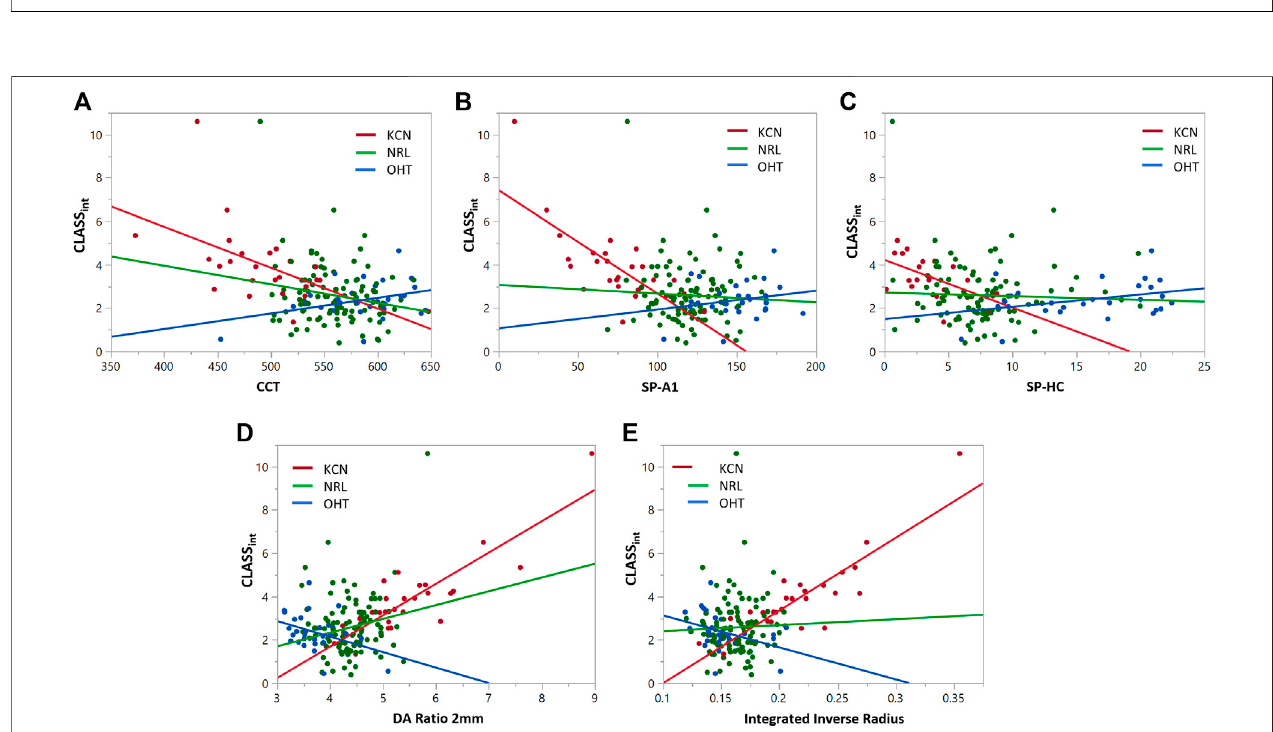
FIGURE 6 | Regression analyses for CLASS int vs. (A) CCT, (B) SP-A1, (C) SP-HC, (D) DA ratio 2 mm, and (E) integrated inverse radius for keratoconic (KCN), normal (NRL), and ocular hypertensive (OHT) subjects.